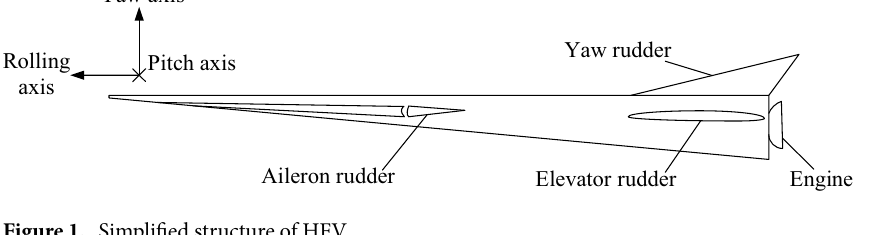
Figure 1. Simplified structure of